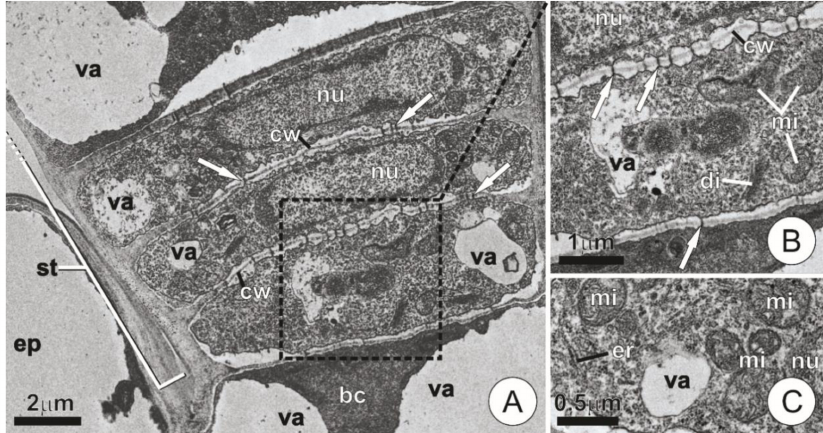
Figure 3. Ultrastructure of a trichome stalk and basal cells. ( A , B ) Longitudinal section showing overall aspect ( A ) and detail of the dotted area ( B ). Note the cells with thin walls largely connected by plasmodesmata (arrows). ( C ) Detail of a stalk cell showing dense, mitochondria-rich cytoplasm. (bc = basal cell; di = dictyosomes; ep = ordinary epidermis cell; er = endoplasmic reticulum; mi = mitochondria; nu = nucleus; st = stalk; va =